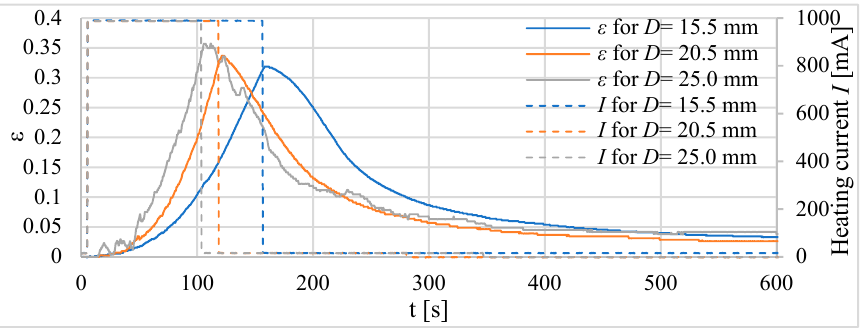
Figure 12. Absolute elongation for tube actuators of equal length and different diameters. Figure 13. Relative elongation ε for actuators of equal length and different diameters. For tube actuators, for most of the examined cases, after reaching the temperature of 75 °C, the relative elongation was between 0.26 and 0.36. The best results are obtained for the actuator with a diameter of 20.5 mm. The elongation for all tube actuators with equal length was almost the same, e.g., approximately 13 mm. Equation (8) relates the elongation to the temperature rise. It was derived in [16] for an actuator without any housing. Therefore, the displacement of the composite was not